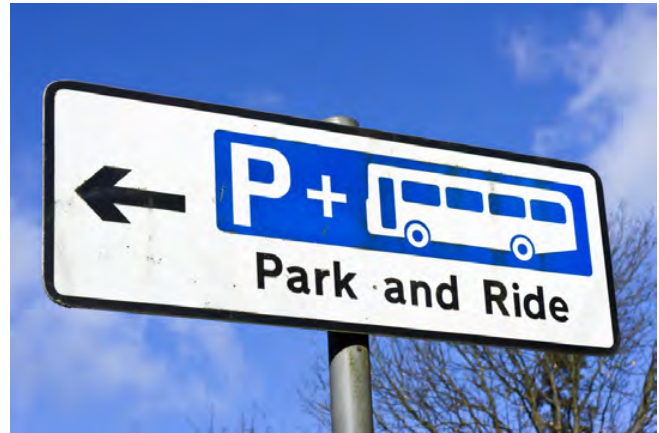
Figure 5. Sign for a park and ride site in a UK town. (UK Construction,2016).